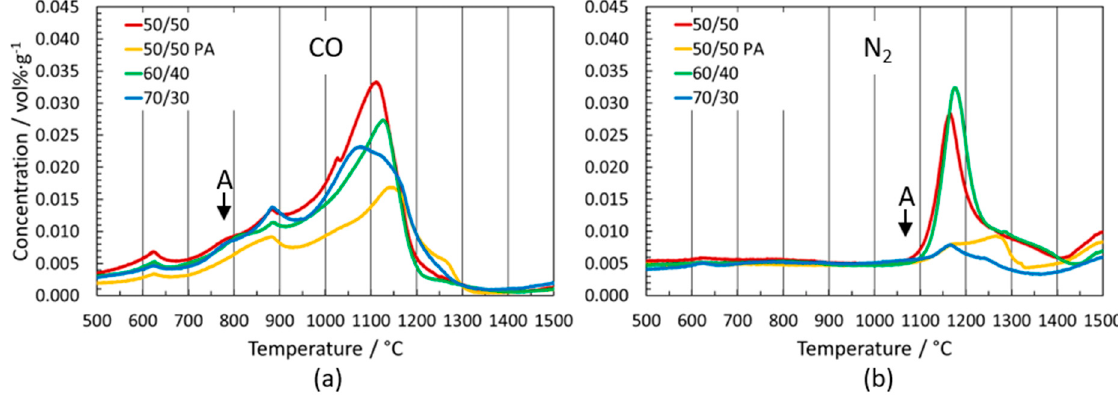
Figure 3. CO ( a ) and N 2 ( b ) outgassing of cermet formulations Ti(C,N)-WC/Mo 2 C-(Ta,Nb)C-Co/Ni with different C/N ratio of the admixed Ti(C,N), nominally Ti(C 0.5 N 0.5 )—“50/50”, Ti(C 0.6 N 0.4 )-A—“60/40” and Ti(C 0.7 N 0.3 ) “70/30” and one grade with admixed “pre-alloyed” (Ti,W)C (“50/50 PA”), corresponding in overall composition to that of the Ti(C 0.5 N 0.5 )-containing formulation.